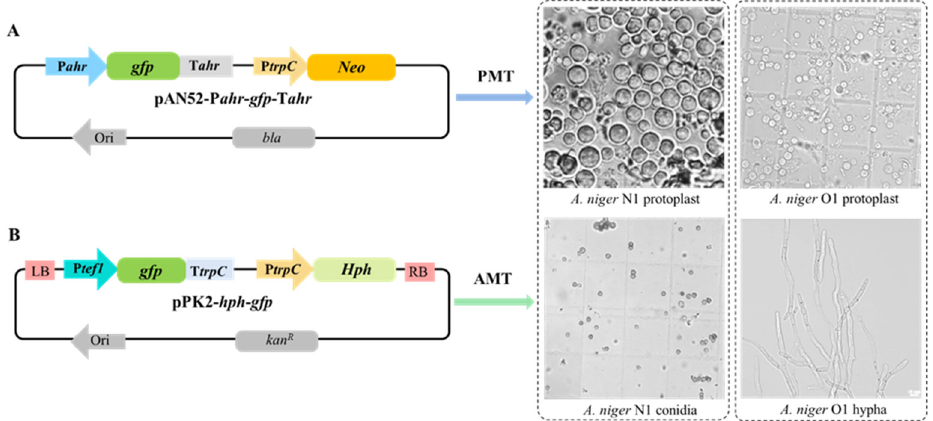
Figure 5. Transformation of A. niger N1 and O1 was carried out by protoplast-mediated transfor- mation (PMT) using the vector of pAN52-P ahr - gfp -T ahr ( A ) and Agrobacterium tumefaciens -mediated transformation (AMT) using the vector of pPK2- hph - gfp ( B ). pAN52-P ahr - gfp -T ahr was transformed into protoplasts of A. niger N1 and O1 by PMT. The pPK2- hph-gfp was transformed into conidia of A. niger N1 and young mycelia of A. niger O1 by AMT. P ahr is the promoter of the alkyl hydroperoxide reductase from M. thermophila ; P tef1 is the promoter of the translation elongation factor gene tef1 from A. niger ; P trpC is the promoter of the tryptophan synthetase gene from A. nidulans ; GFP, enhanced green fluorescence protein; Neo , neomycin-resistance gene; Hph , hygromycin resistance gene; RB and LB, right and left border of T-DNA, respectively.